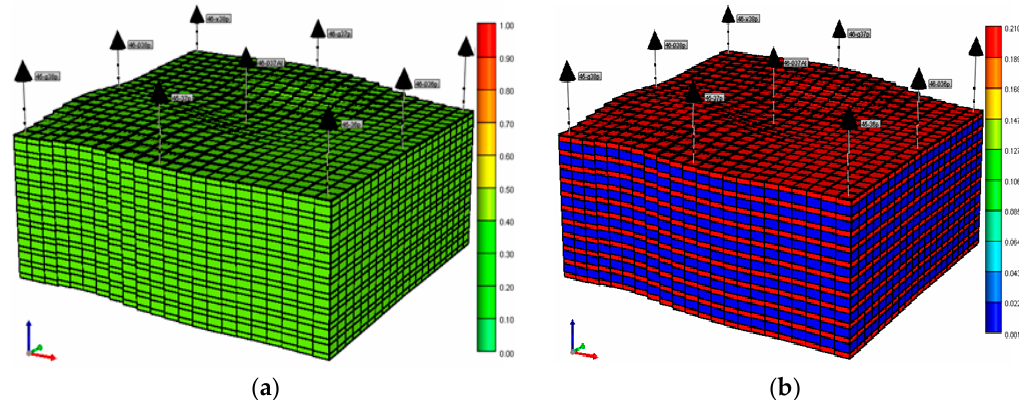
Figure 1. Three-dimensional distribution of the initial oil saturation and porosity. ( a ) Initial oil saturation distribution; ( b ) porosity distribution.